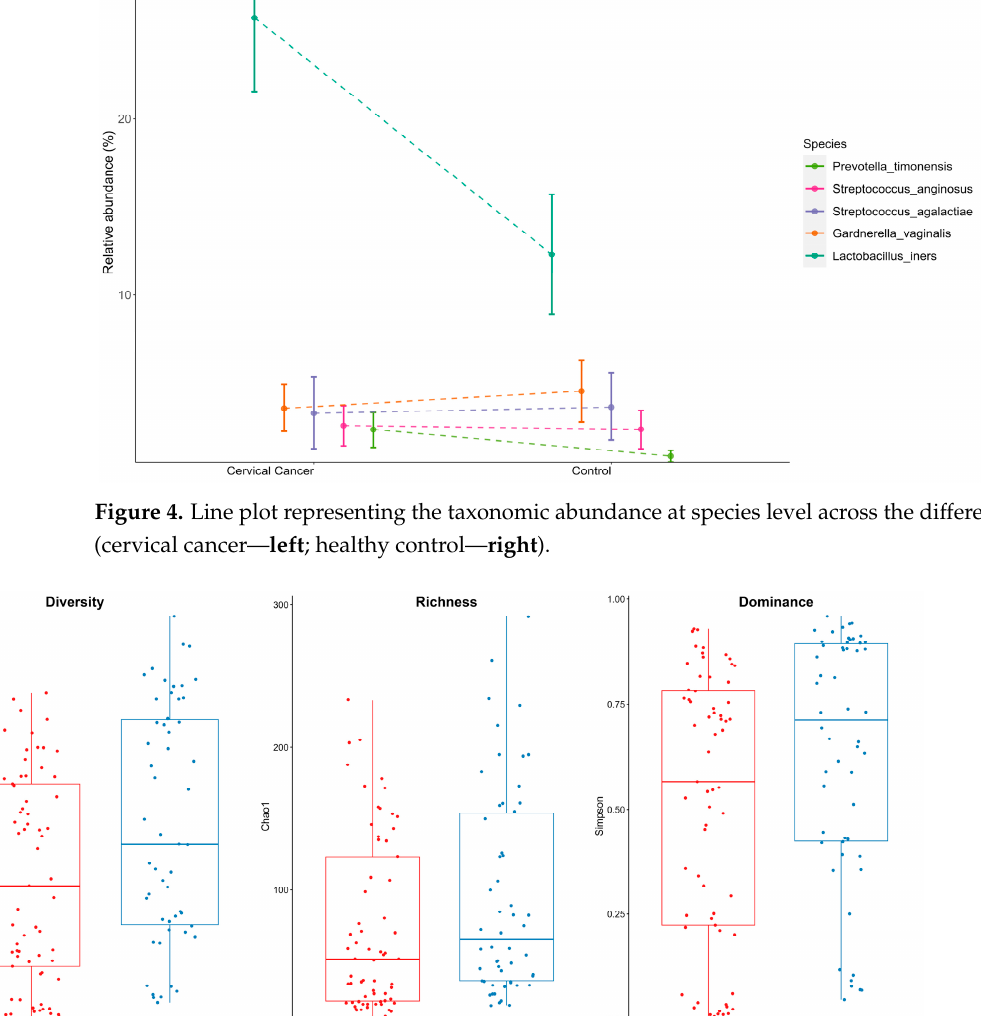
Figure 5. α diversity indexes are plotted as boxplots. α diversity indices are composite indices that capture consistency and abundance. The Shannon and Simpson indices reflect ASV diversity in samples, and the Chao1 measure reflects the ASV abundance in samples.